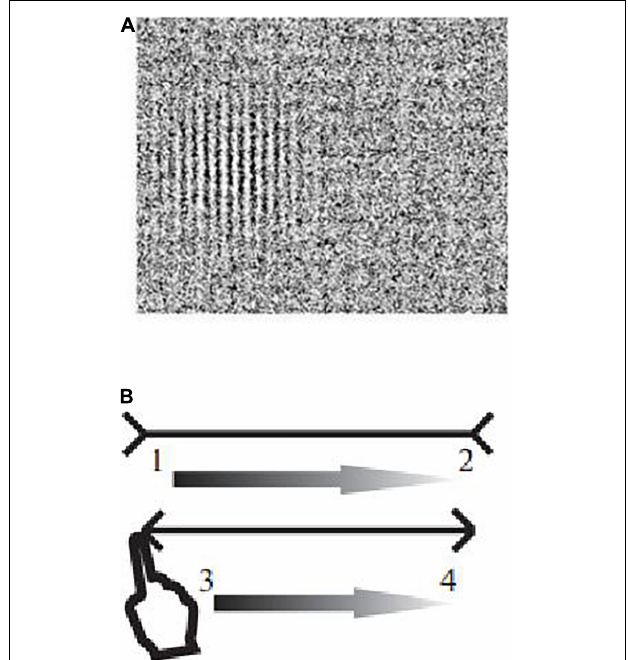
FIGURE 2 | Examples of images in the DI experiment. (A) Examples of images of Gabor elements presented in the study to assess the contrast sensitivity in different ranges of spatial frequencies. (B) The Müller-Lyer illusion (1, 2, 3, 4—the direction of movement of the finger along the segments of the Müller-Lyer